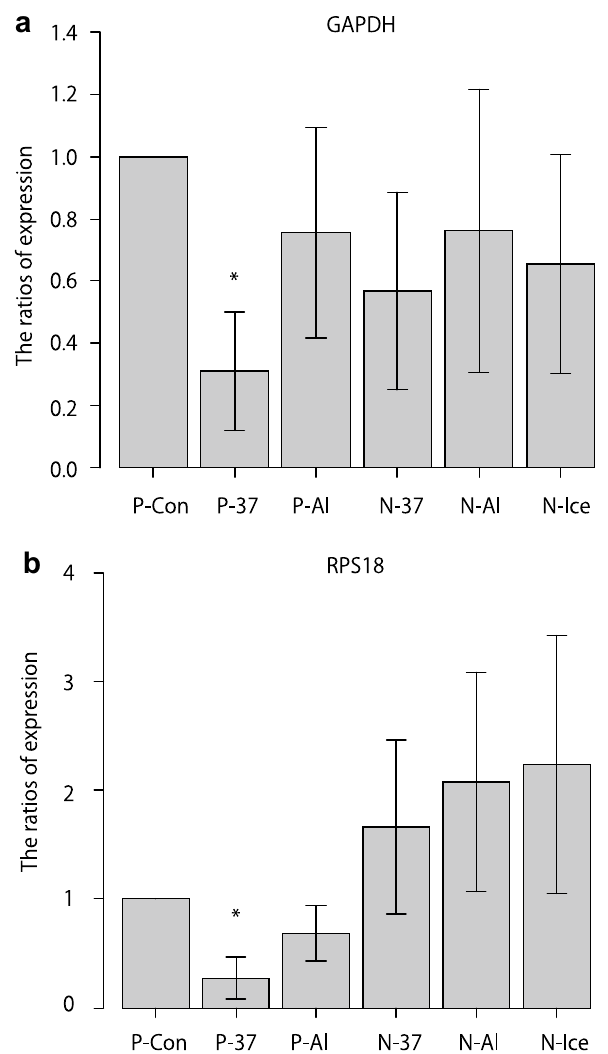
Figure 3. Comparison of GAPDH and RPS18 expression in RNA isolated from whole blood samples using six different protocols. ( a , b ) Data are shown for each sample as mean ± standard deviation (n = 7). ( a ) * p < 0.05 for P-Con versus P-37 and P-37 versus P-Al (repeated-measures analysis of variance with Bonferroni correction). ( b ) * p < 0.05 for P-Con versus P-37, P-37 versus N-37, and P-37 versus N-Al (repeated-measures analysis of variance with Bonferroni correction). GAPDH glyceraldehyde 3-phosphate dehydrogenase, RPS18 ribosomal protein S18. The images were created using EZR software version 1.54 (http:// www. jichi. ac. jp/ saita ma- sct/ Saita maHP. files/ statm edEN. html), Microsoft Excel 2016 MSO (16.0.14131.20278) 32 bit (https:// www. micro soft. com/) and Adobe Illustrator CS5 (https:// www. adobe.